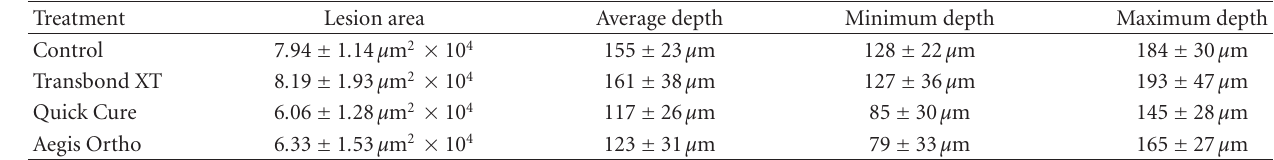
Table 2: PLM lesion measurements after 42 days of pH